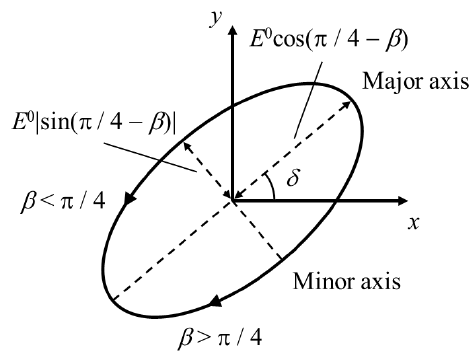
Figure 1. Orientation of the polarization ellipse. The laser field propagates in the z direction and oscillates in the xy plane. The orientation angle of the major axis of the polarization ellipse with respect to the x axis is represented by δ . The minor-to-major axial ratio is |tan ( π /4 − β )|. Modified from [56] with permission of the American Chemical Society.